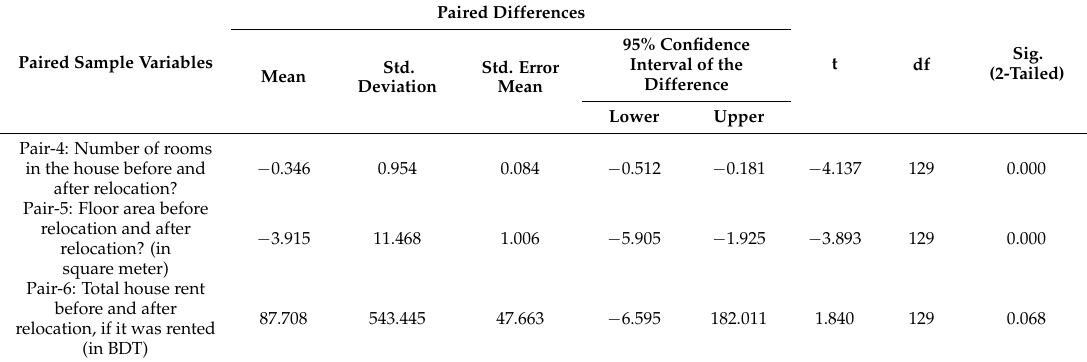
Table 6. Housing condition before and after relocation.